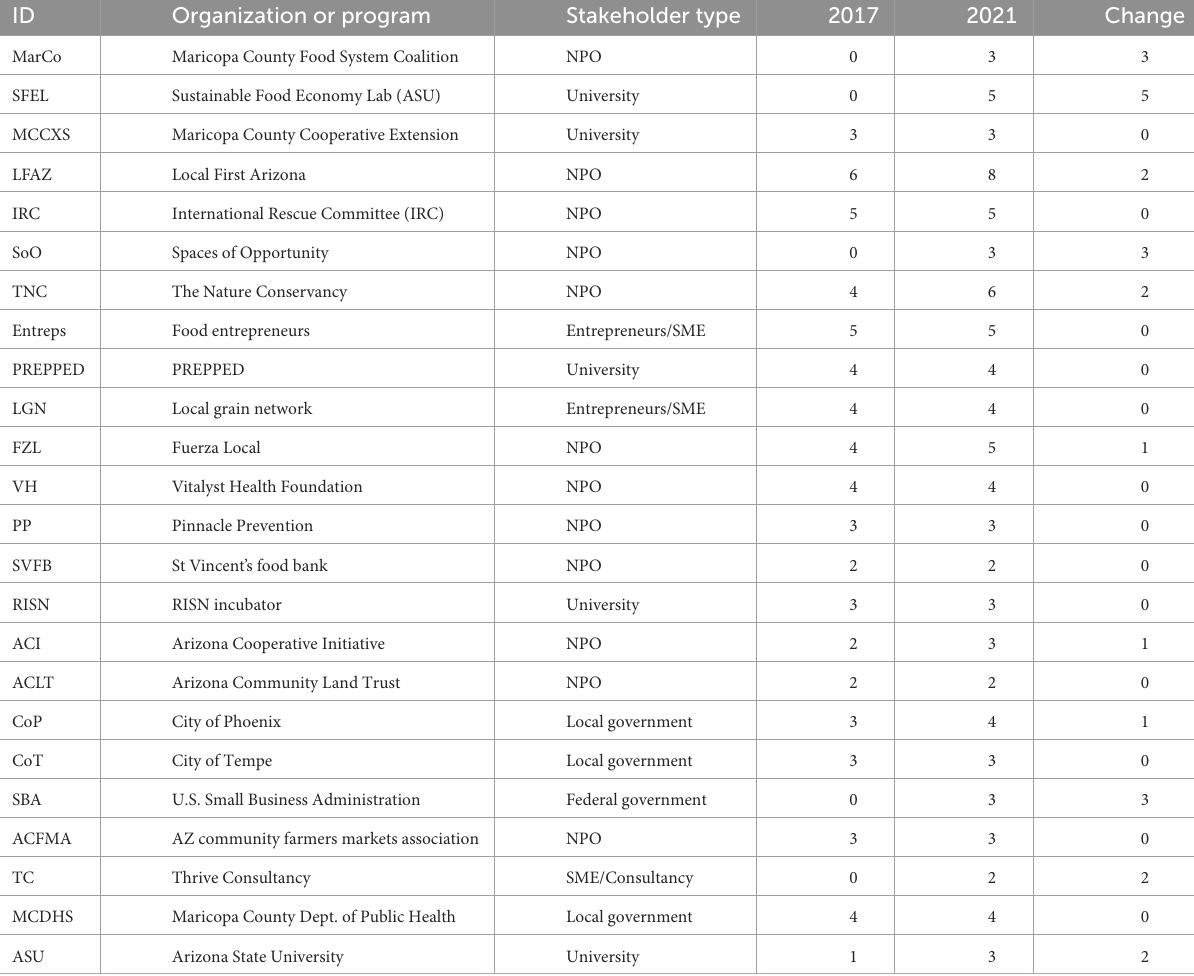
TABLE 7 SEE stakeholders in the Phoenix area, showing the number of functions participated in in 2017 and 2021 and the net change.